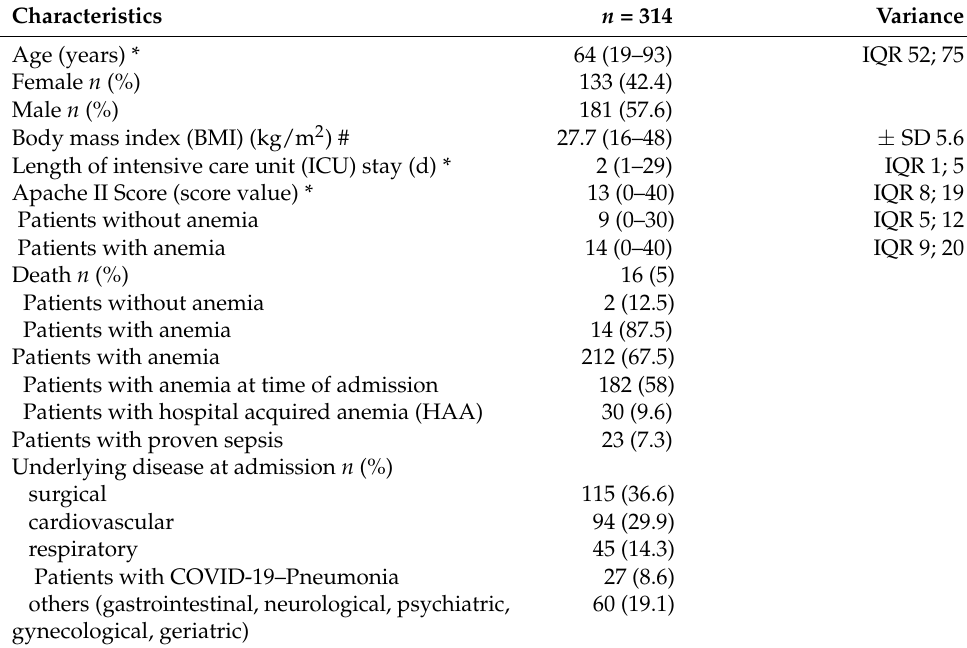
Table 2. Demographic data of the study